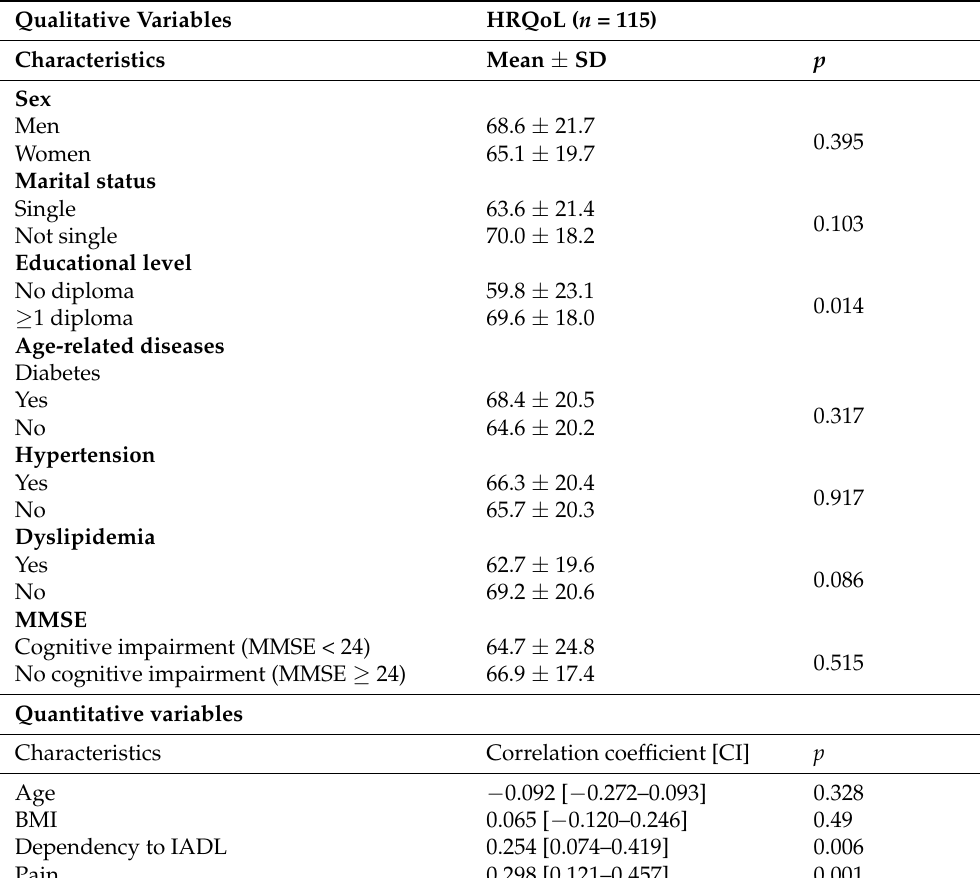
Table 2. Associations between HRQoL score and patient’s characteristics. Qualitative